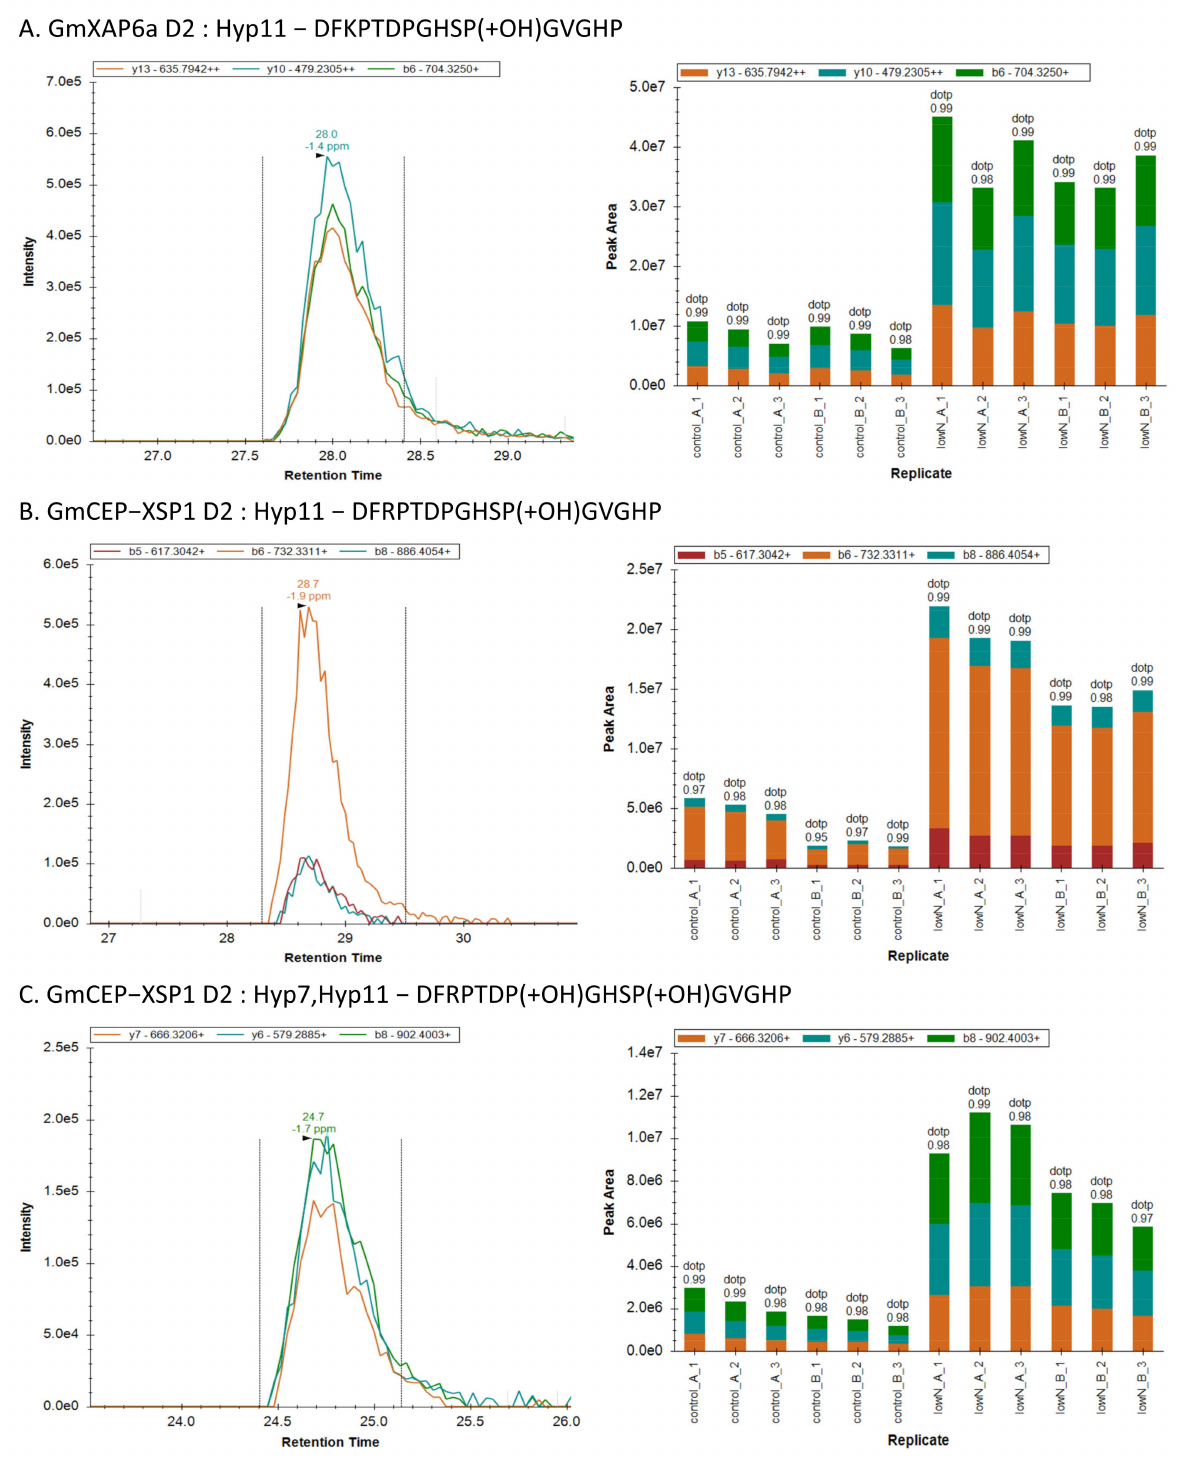
Figure 4. Parallel reaction monitoring (PRM) assay of peptides: ( A ) GmXAP6a:Hyp11, ( B ) Gm- CEPXSP1:Hyp11, and ( C ) GmCEPXSP1:Hyp7,Hyp11 in soybean xylem sap under normal (control) and nitrogen-deficiency (Low N) conditions. The left panels show the extracted ion chromatogram of the three transitions (fragment ions) selected for quantification. The right panels show the peak areas of each technical replicate plotted in the bar chart. The experiment was performed in biological replicates ( A , B ) and technical triplicates (1–3) for each